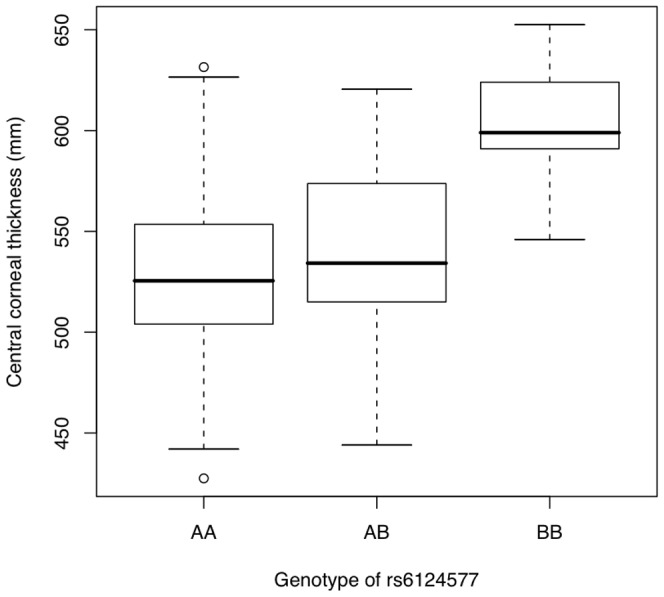
Distribution of central corneal thickness.A boxplot of CCT measurements is presented, demonstrating the differential thickness based upon the observed genotype at rs6124577.